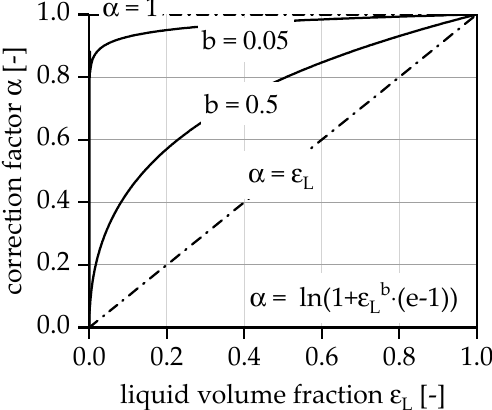
Figure 7. Constructed relationship between correction factor α and liquid volume factor ε L .